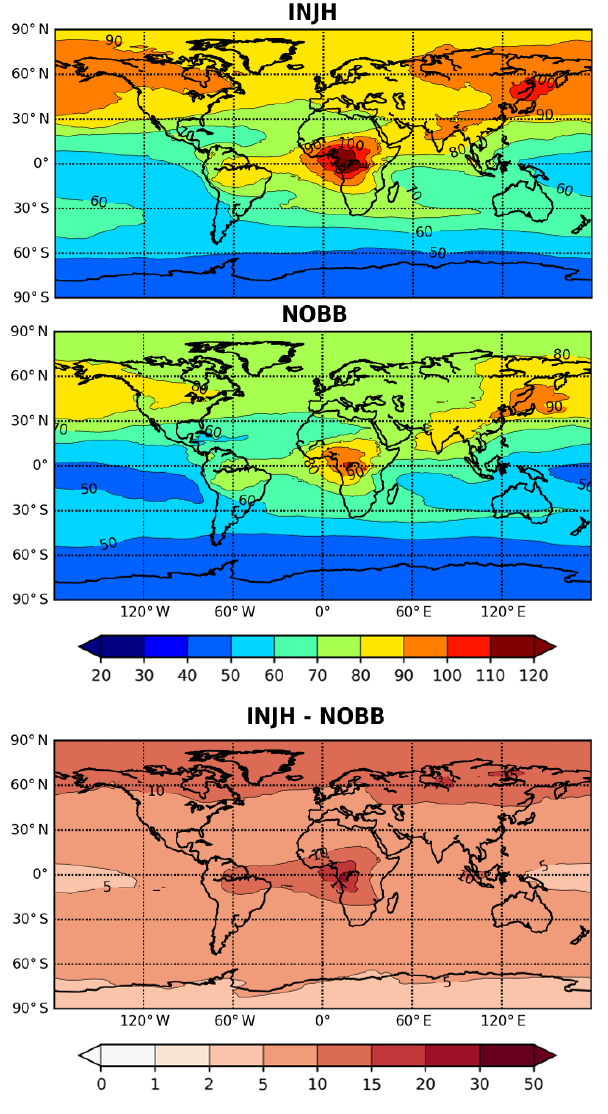
Figure 13. Map of 2013 upper tropospheric mean mixing ratios of CO for the INJH and NOBB simulations, as well as the absolute difference between the